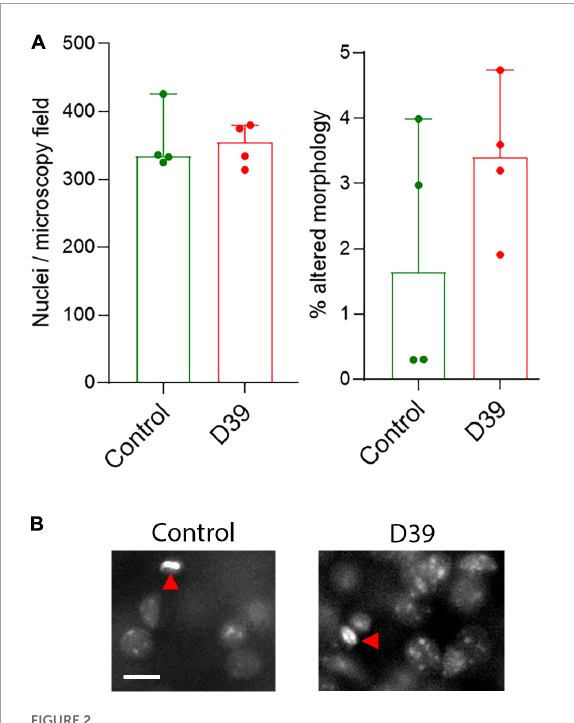
FIGURE2 (A) Lack of significant difference in the number of nuclei in layers 1–3 (left) and in the fraction of nuclei with pathologic (condensed, fragmented) morphology in both animal groups. All values represent median ± 95% CI, Mann-Whitney U-test. Each animal is indicated as a separate symbol in the scatter plot. For mock-infected animals (control), n = 4 animals, for D39-infected mice (D39), n = 4. (B) Morphological example of nuclear stain of cells in the superficial layers of the neocortex. We did not observe any polymorphonuclear lymphocytes (neutrophils) to indicate an increased parenchymal infiltration at this point. Red arrows point to individual cells with altered (in this example pyknotic) nuclear morphology. Scale bar: 10 µ